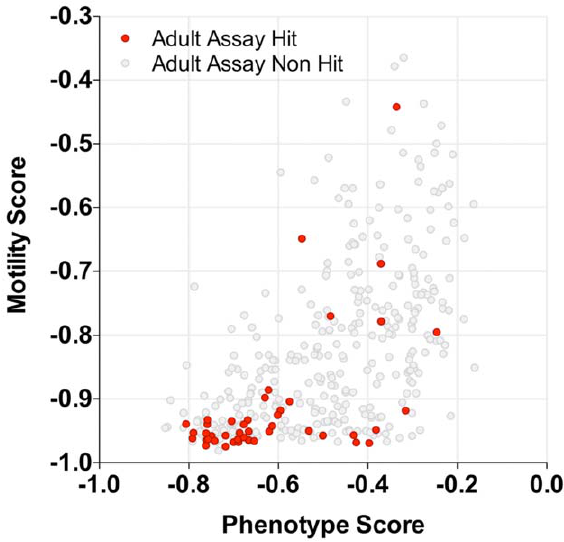
Figure 7. Secondary adult hit screening of larval hits for the Dundee 10,041 Compound Library. Larval phenotype and motility scores for the compounds which were tested in the secondary adult assay. Adult hits are depicted in red and non-hits in grey.